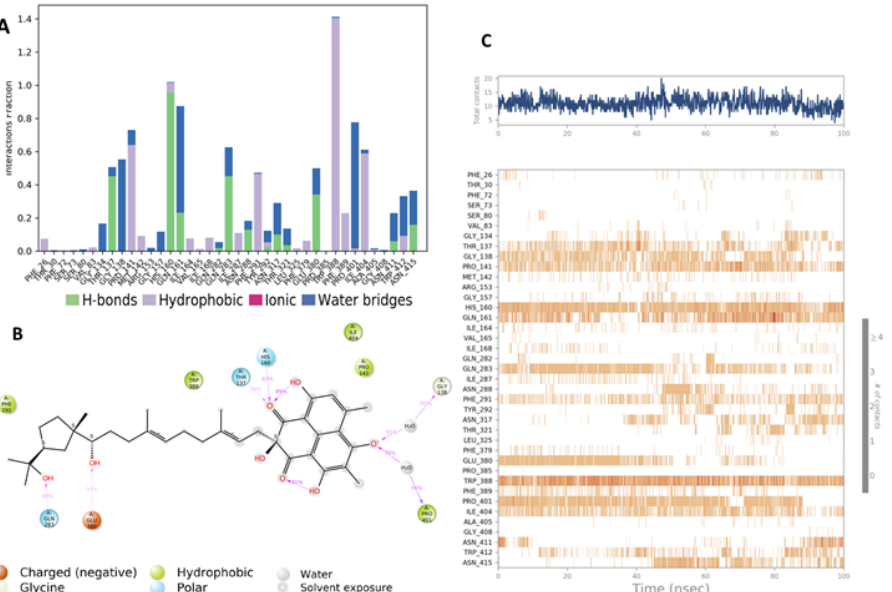
Figure 23. ( A ) The interaction of GLUT1 (PDB: 5EQG) with the native inhibitor 64 throughout the simulation. The interactions between the ligand and protein were classified into hydrophobic, hydrogen bond, ionic, and water bridge interactions. The stacked bar charts were normalized over the course of the trajectory: for example, a value of 0.65 suggested that the interaction with the specific amino acid residue was maintained during 65% of the simulation time. Values over 1.0 implied that some protein residues made multiple interactions of the same subtype with the ligand. ( B ) Schematic diagram showing the detailed 2D atomic interactions of 64 with GLUT1, occurring > 30% of the simulation time in the selected trajectory (0 through 100 ns). Interactions with >100% occurrence meant that residues may have multiple interactions of a single type with the same ligand atom. ( C ) A timeline representation of the GLUT1- 64 interactions shown in ( A ). The panel on top illustrated the total number of specific interactions the protein made with the compound over the course of the trajectory. The panel below illustrates which residues interacted with the ligand in each trajectory frame. The dark or orange color indicates that more than one specific interaction was made between some residues and the